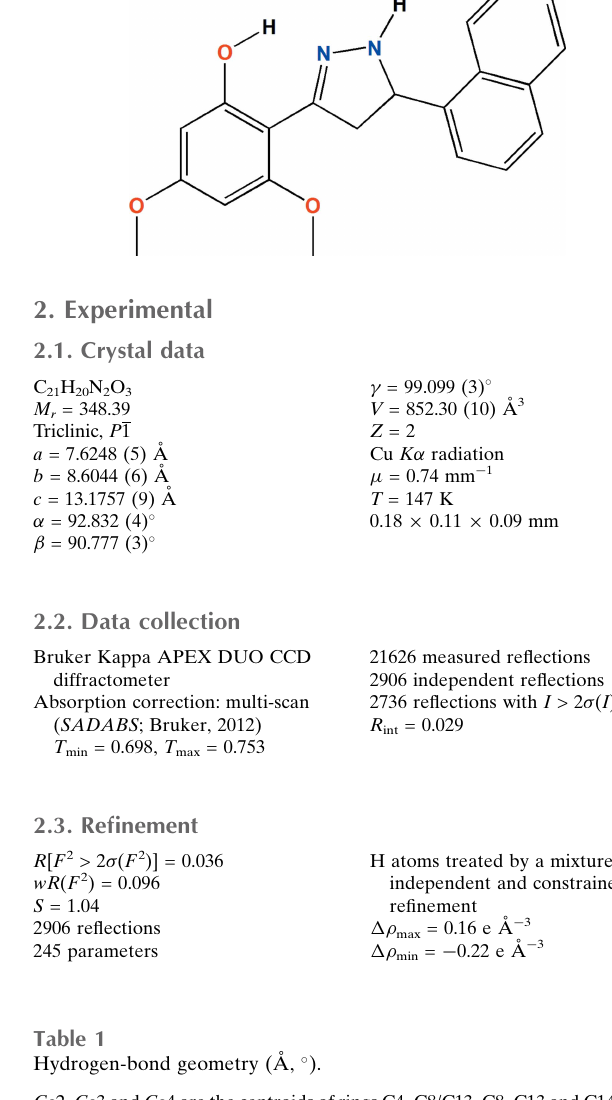
Hydrogen-bond geometry (A˚ , (cid:2)